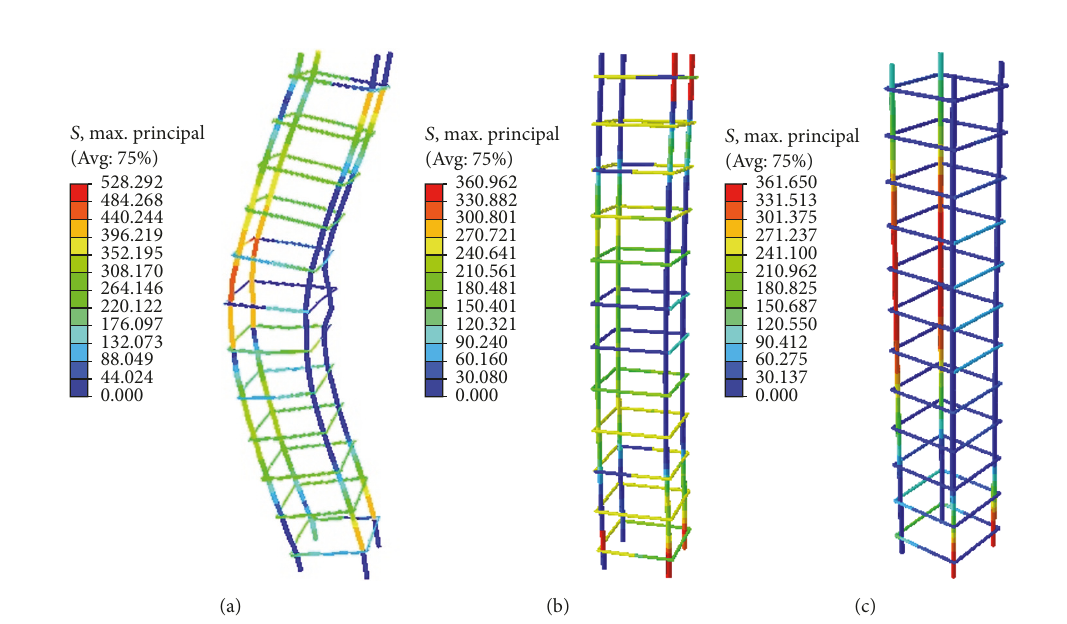
Figure 14: Lateral displacement of column’s middle height.